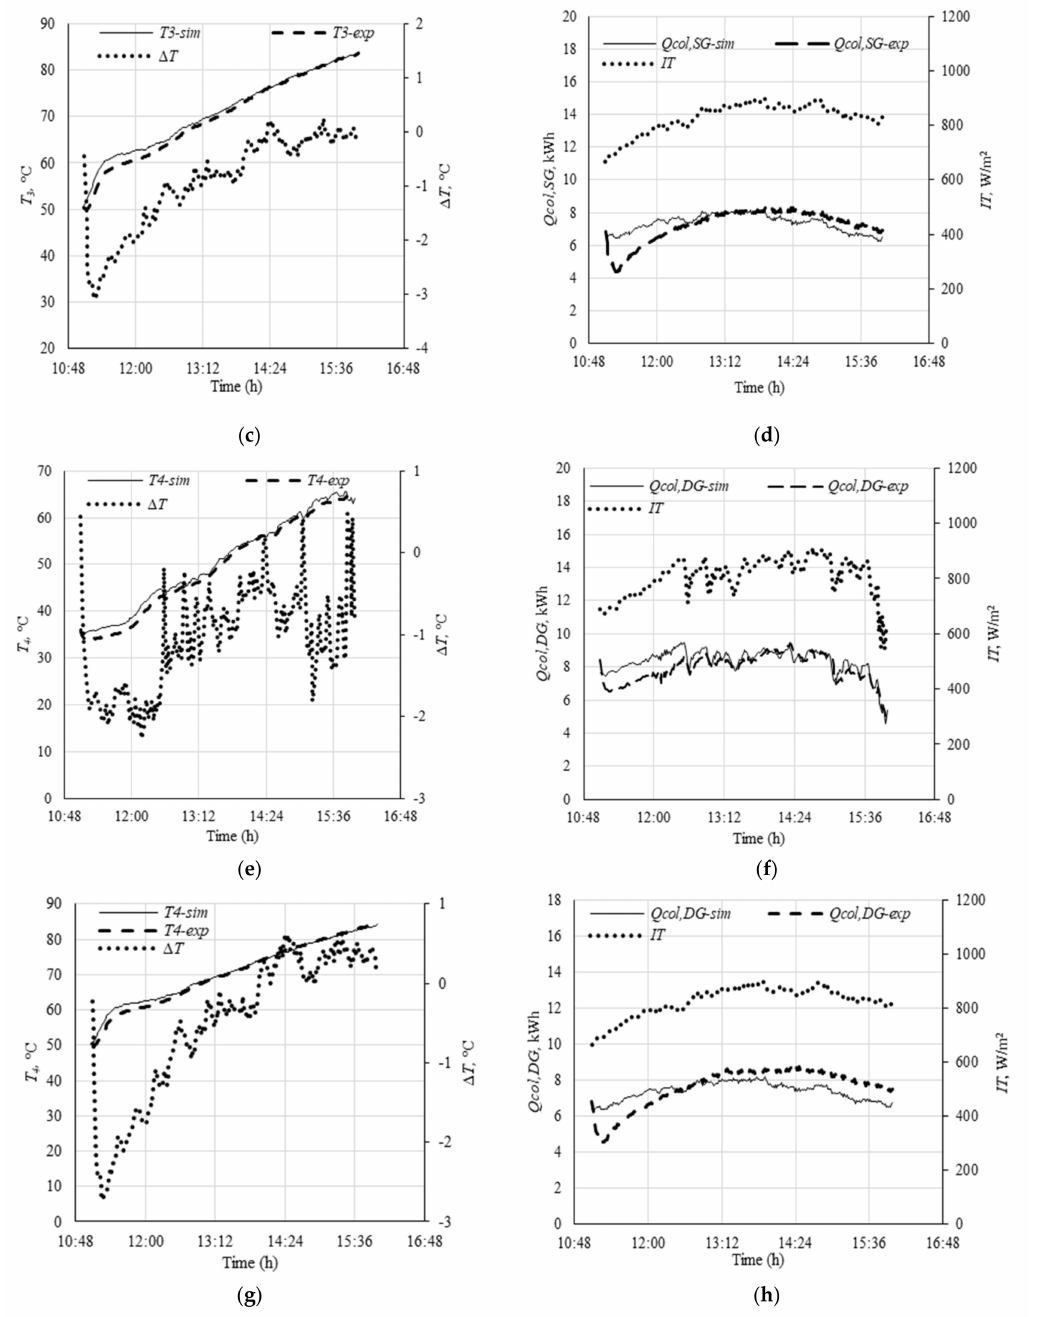
Figure 6. Solar water collectors theoretical–experimental outlet temperature and useful energy comparison. ( a )